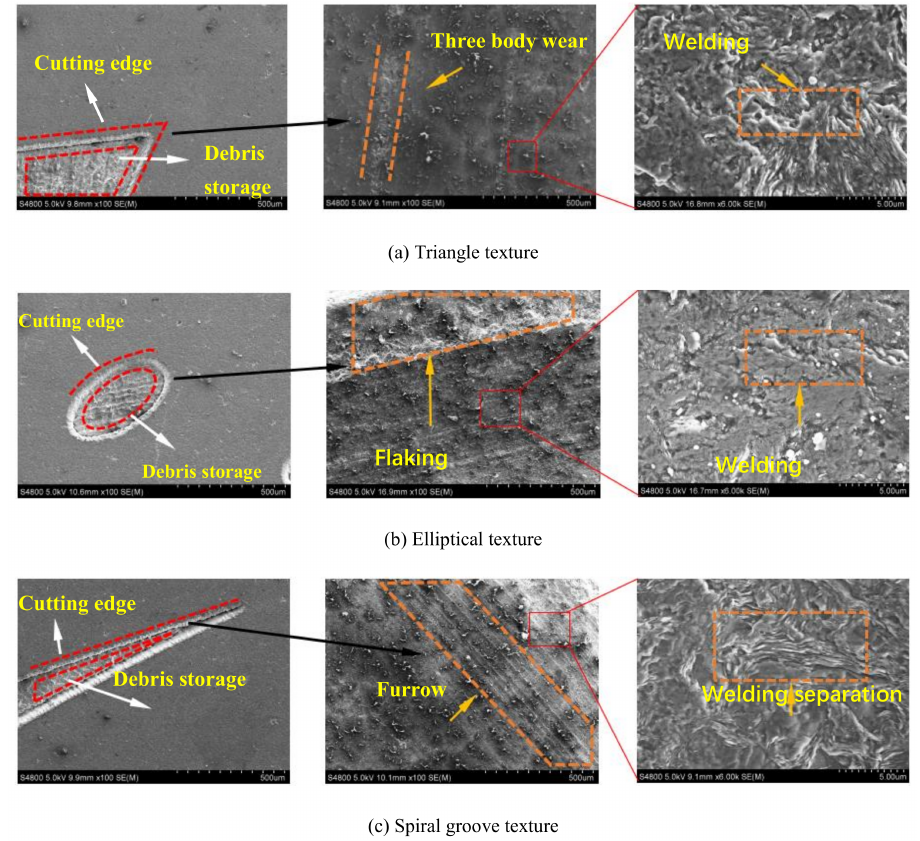
Figure 9. Surface morphologies of specimens with triangular texture ( a ), elliptical texture ( b ), and spiral groove texture ( c ) after